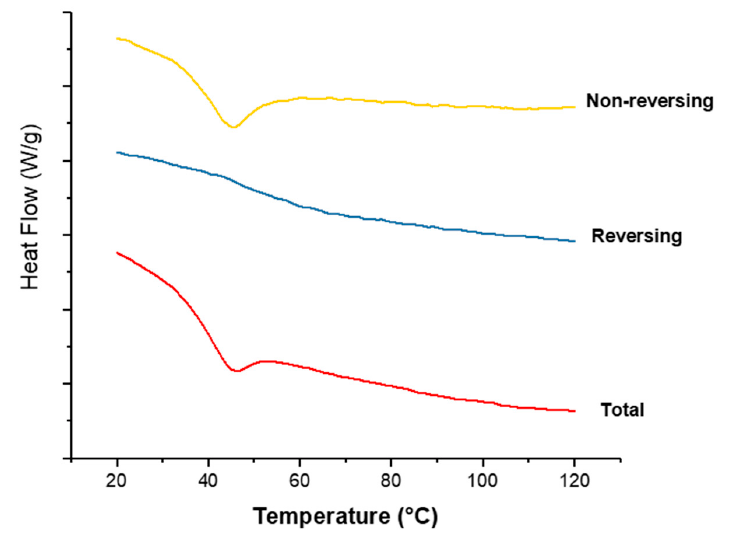
Figure 9. MTDSC thermogram of co-axial system 2 which contained KCT in the core with CPM, and E-EPO in the shell. Exo up.